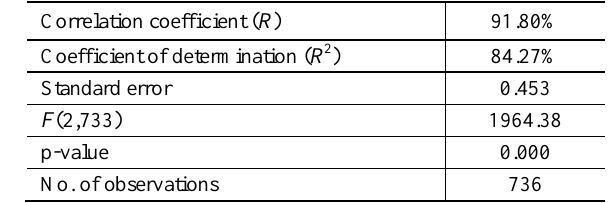
Table 4. Overall regression model statistics for micro-level